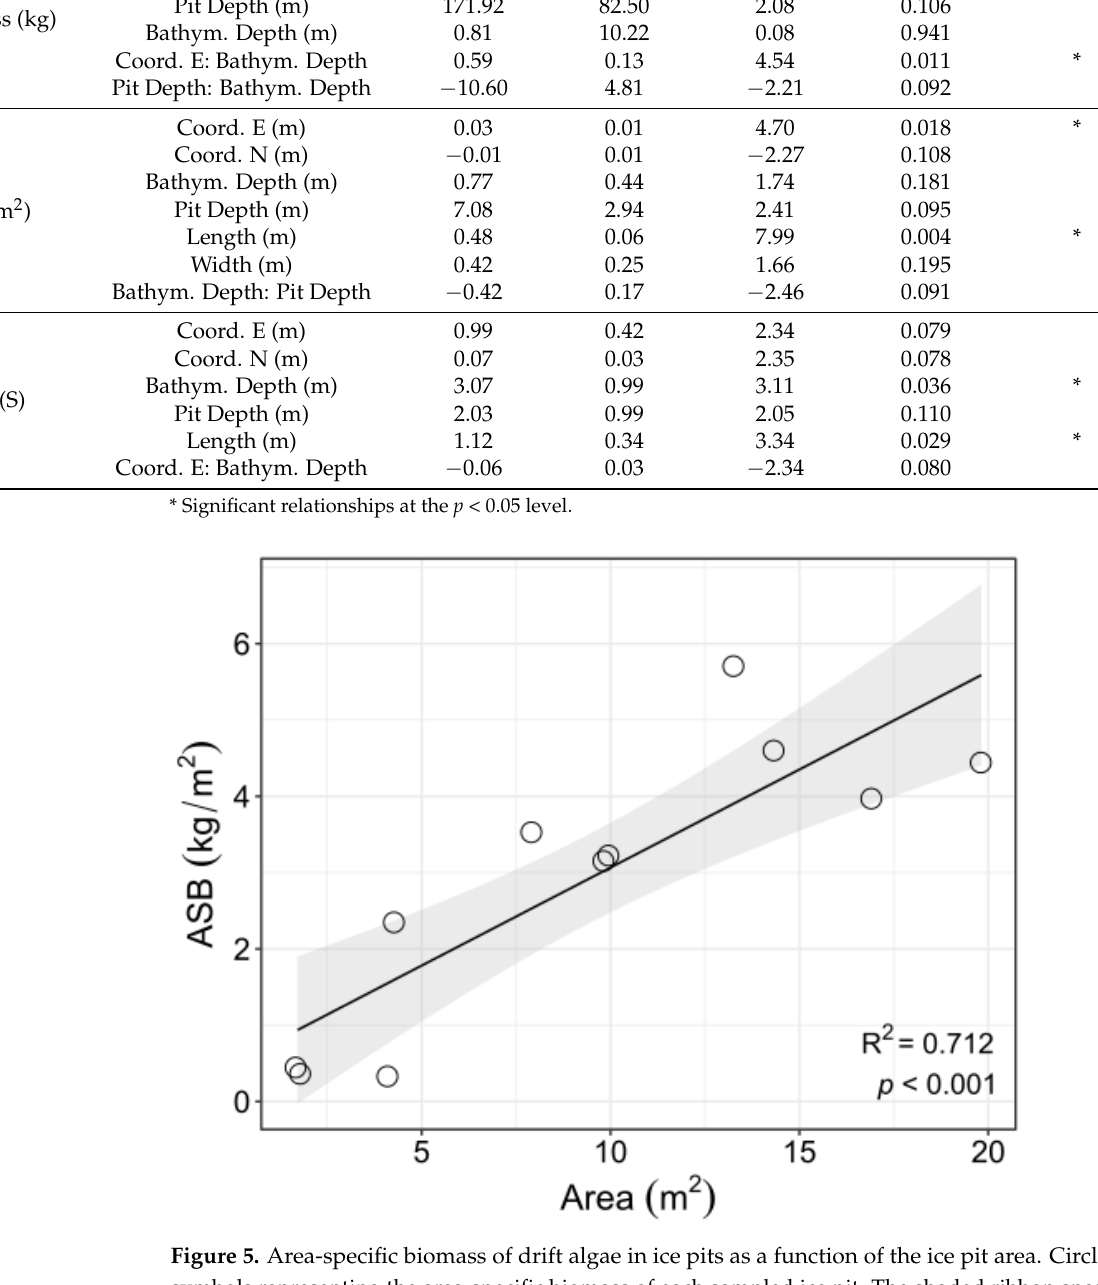
Figure 6. Non-metric multidimensional scaling (nMDS) ordination of the relative biomass of 16 algal species using Bray-Curtis dissimilarity. Each quadrat sample (two for each ice pit) is labeled and colored according to the ice pit and sized relative to the area (m 2 ) of the ice pit. Vectors indicate algal species (gray) and environmental variables (red) with significant fit to the ordination at the p < 0.01 level.